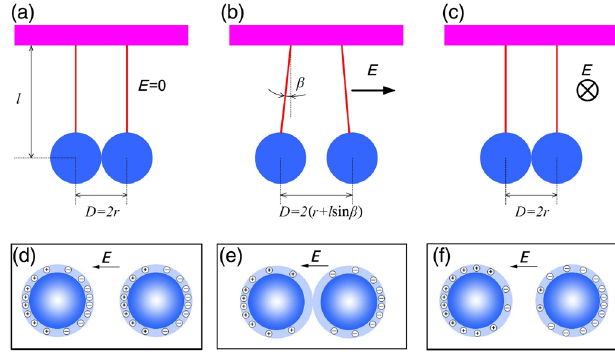
FIG. 3. Experiments within silicone oil: (a) – (c) Two contacting glass beads ( r ¼ 1 mm) placed on fibers hanging down a bar.